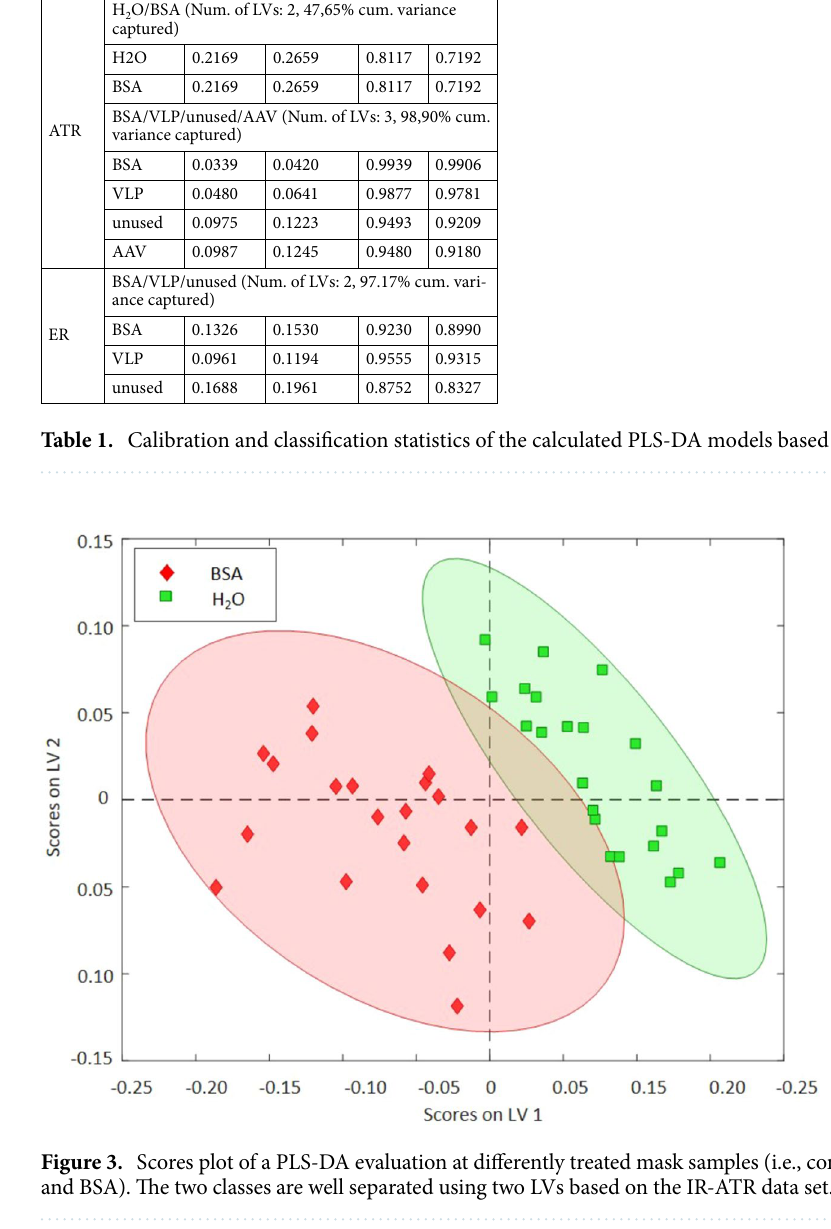
Table 1 summarizes the obtained classification results along with their statistical characterization for all generated PLS-DA models. The coefficient of determination (R 2 ) values for calibration and CV verifies a high predictive accuracy of the generated model, as both values are > 0.7. As shown in Fig. 3, the PLS-DA model classifies the masks according to the exemplary analytes H 2 O and BSA. The loadings on LV 1 and LV 2 of this model describe parts of the characteristic H 2 O bending vibration around 1640–1670 cm −1 . More precisely, a sharp narrow part of the water bending vibration is described, and thus, a structural change of this vibrational mode is indicated. Additionally, the signal at approx. 1390 cm −1 increase in the loadings (see SI Fig. 1). Previ- ous publications have investigated water dispersion and diffusion into polypropylene (PP) films 31,32 . Shen et al. determined the presence of water molecules within the PP matrix. Even if PP has a low permeability compared to other polymers, their results have indicated molecular interactions between water molecules and the polymer matrix. The corresponding analysis of the obtained IR-ATR spectra in the present studies verified these findings via the O–H bending vibration in the range 1750–1540 cm −132 . These results indicate that residual water may be readily detected in surgical mask materials, even after a considerable drying time (here, 2 h). In Fig. 3, a minor overlap of confidence ellipses (95%) is evident, which is attributed to the spectral similarity of neat water to the H 2 O bending vibration in BSA, as it has been dissolved in aqueous solution.